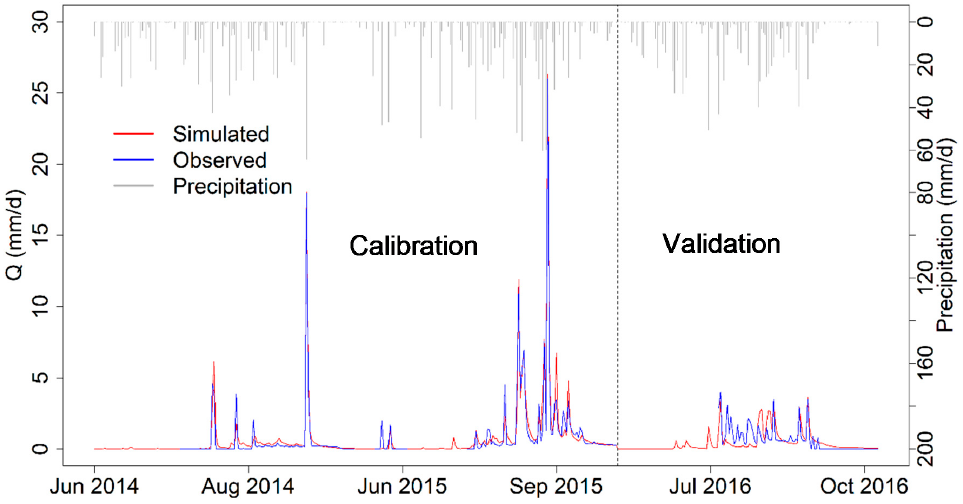
Figure 7. Comparison of the simulated and observed hydrographs for the upstream sub ‐ catchment (Bankandi ‐ north). The vertical dash line separates the calibration period from the validation period.